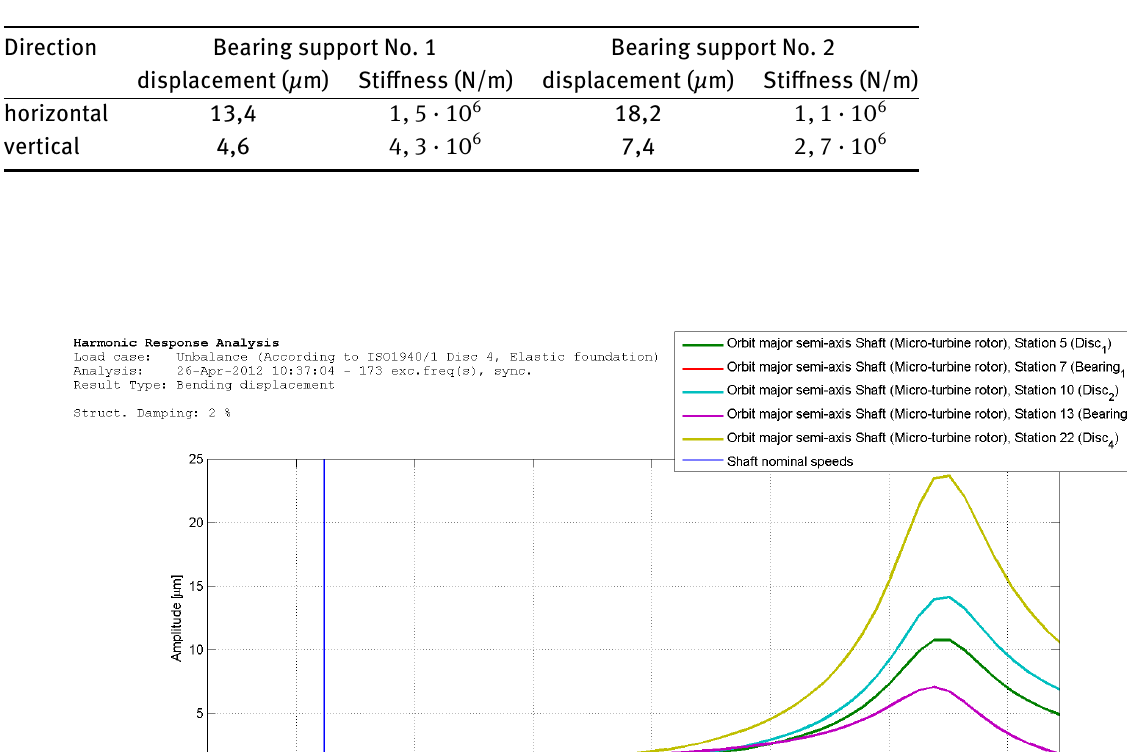
Table 3: Calculated static stiffness of the bearing supports.